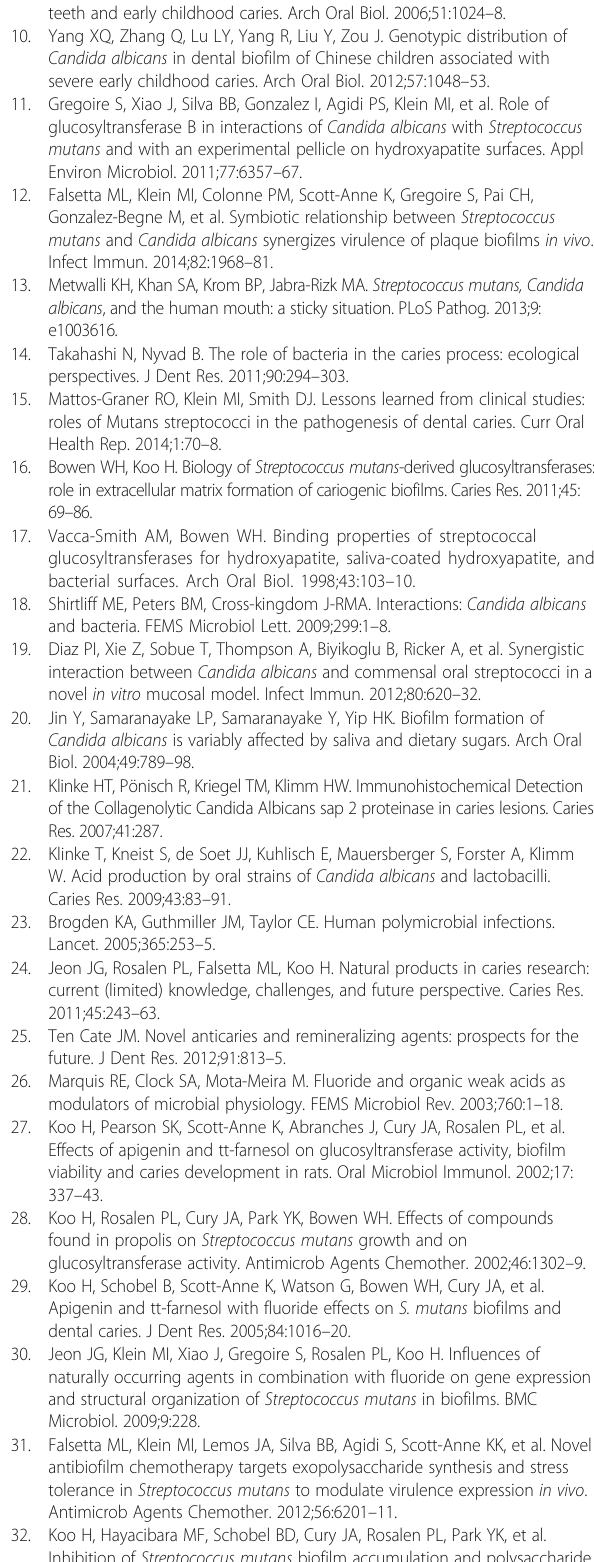
Abbreviations 3D: Tridimensional; ASP: Alkali soluble polysaccharides; CHX: